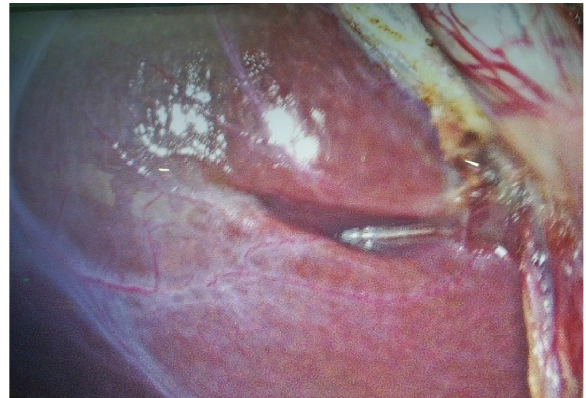
Figure 1: Open type, transverse RS.